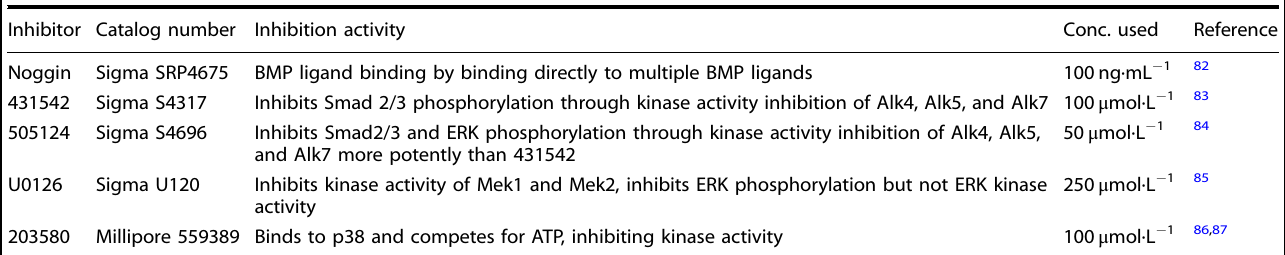
Table 1. Protein and small molecule inhibitors used in cultured spine treatments Inhibitor Catalog number Inhibition activity Conc. used